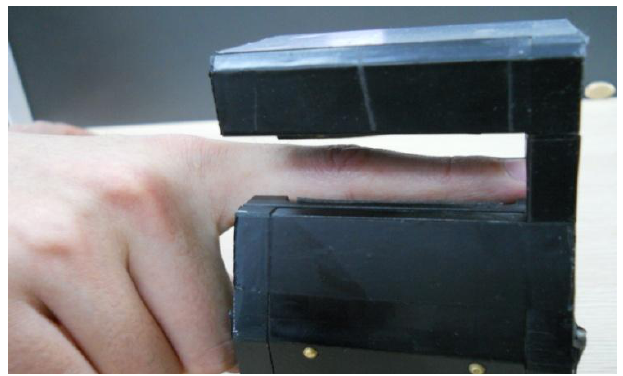
Figure 6. The finger vein image capture